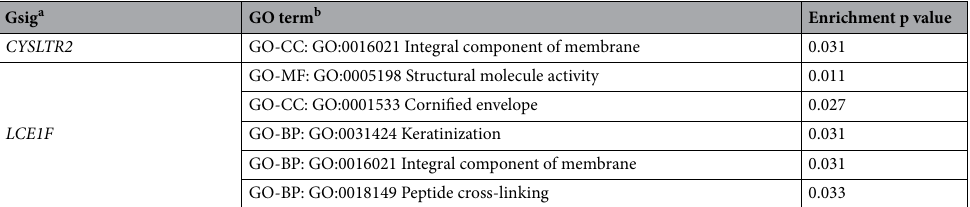
Table 5. Top significant GO terms enriched with the Alzheimer’s disease specific genes. a Gsig: genes belonging to the gene signature. b For GO terms, it has three domains: Biological Process (BP), Cellular Component (CC), and Molecular Function